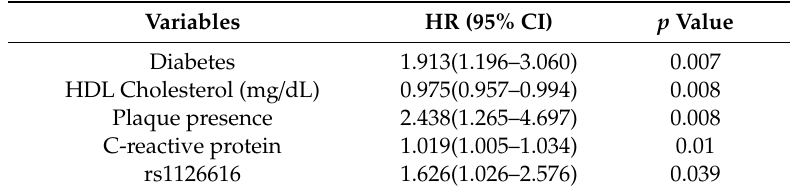
Table 5. Cox regression modelling the incidence of CVE excluding dialysis patients ( n = 1021).